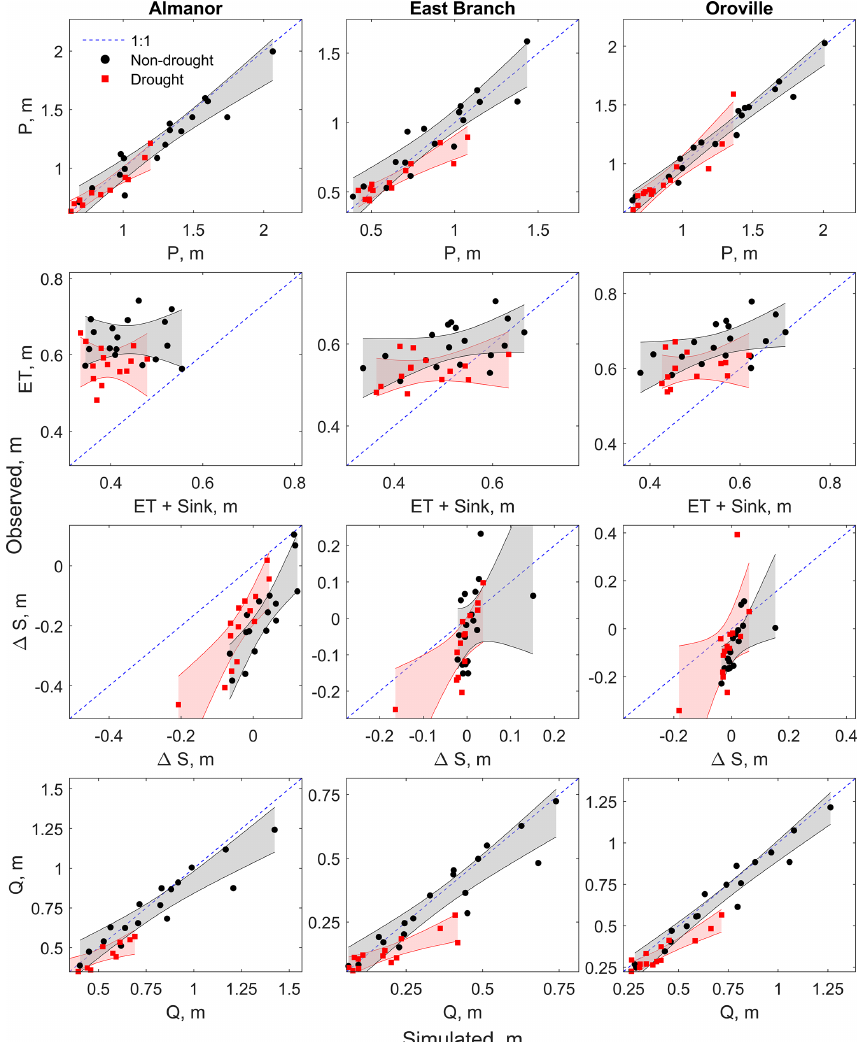
Figure 8. Simulated vs. observed annual basin-wide water-balance components ( P , ET, (cid:49)S , and Q ) separated between drought (red) and non-drought (black) years. Simulated annual ET includes the groundwater-sink mass-flux component (see Sect. 2.3.3). The red and grey bands represent 95% confidence intervals for the